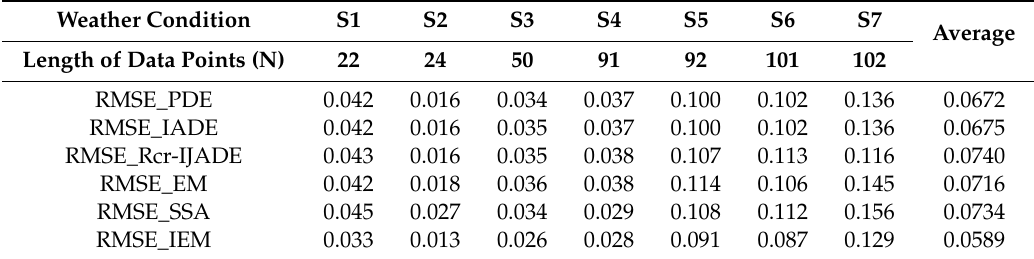
Figure 8. Root mean square error (RMSE) values of IEM, slap swarm optimization (SSA), EM, Rcr- IJADE, adaptive differential evolution (IADE), and penalty-based differential evolution (PDE) algorithms at various weather conditions.